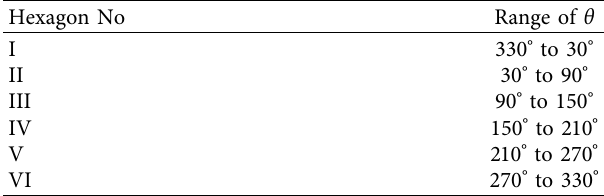
Table 3: Mapping of V